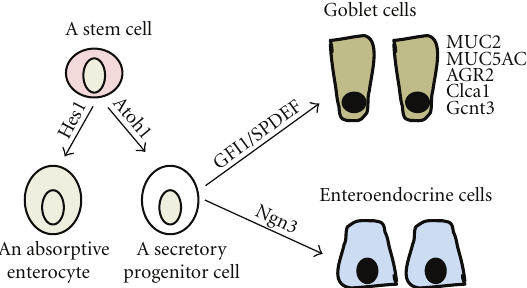
Figure 2: The di ff erentiation path of a goblet cell starting from a progenitor and the genes involved in this process. An intestine stem cell becomes an absorptive cell in the absence of the Atoh1 protein but activation of Hes1 or becomes a secretory progenitor cell under the influence of Atoh1 protein with the potential to become either enteroendocrine cells under the direction of neurogenin 3 (Ngn3) or goblet cells under the direction of GFI1 and SPDEF.